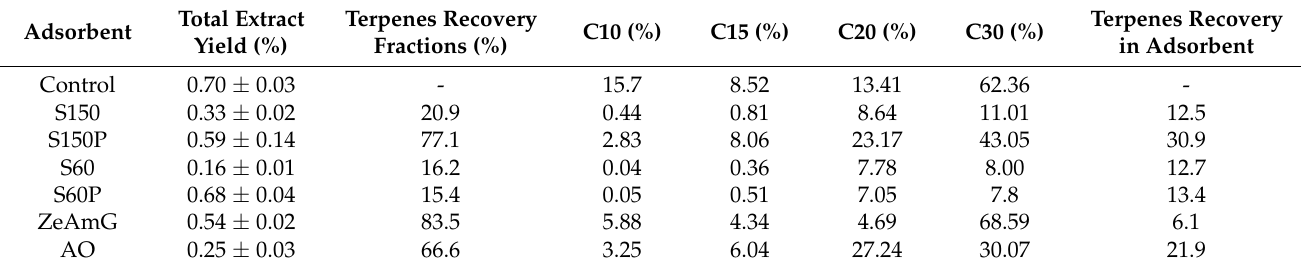
Table 3. Total yield of the SFE process used as control vs. SFE using different adsorbents (the latter includes terpenes recovery in the fractions and in the adsorbent after completing the process). Total Adsorbent